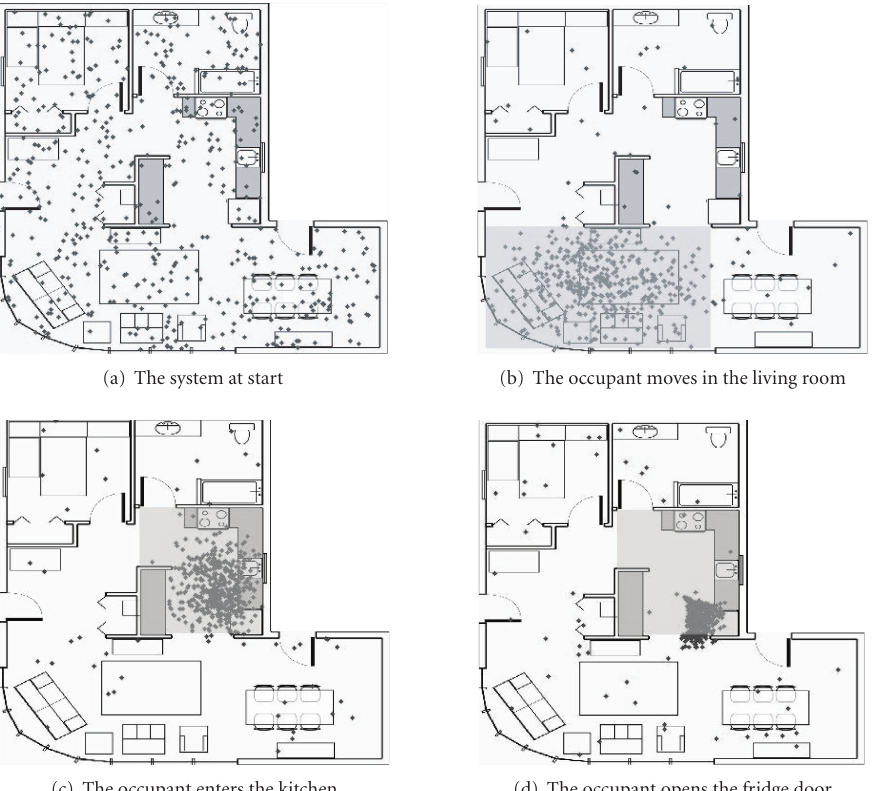
Figure 1: The localization system in a real condition situation. The points show the particle cloud. The shaded areas indicate where the occupant is likely to be